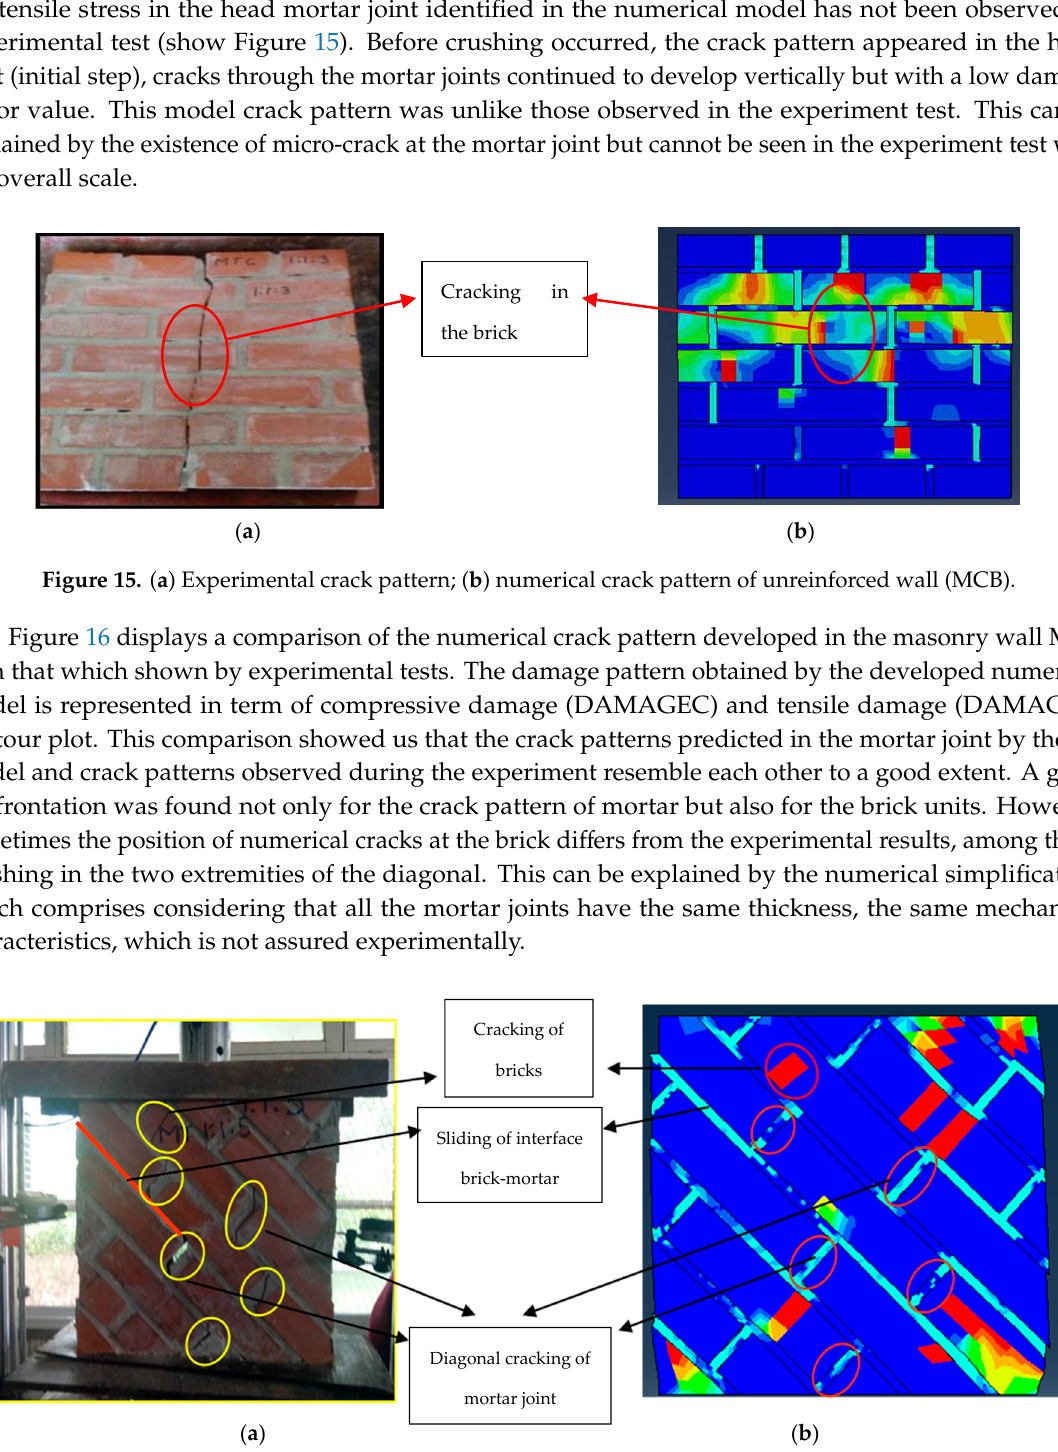
Figure 14. ( a ) Von Mises stress; ( b ) normal stress in the direction y (S22); ( c ) evolution of damage in unreinforced wall MTB (θ = 45°).